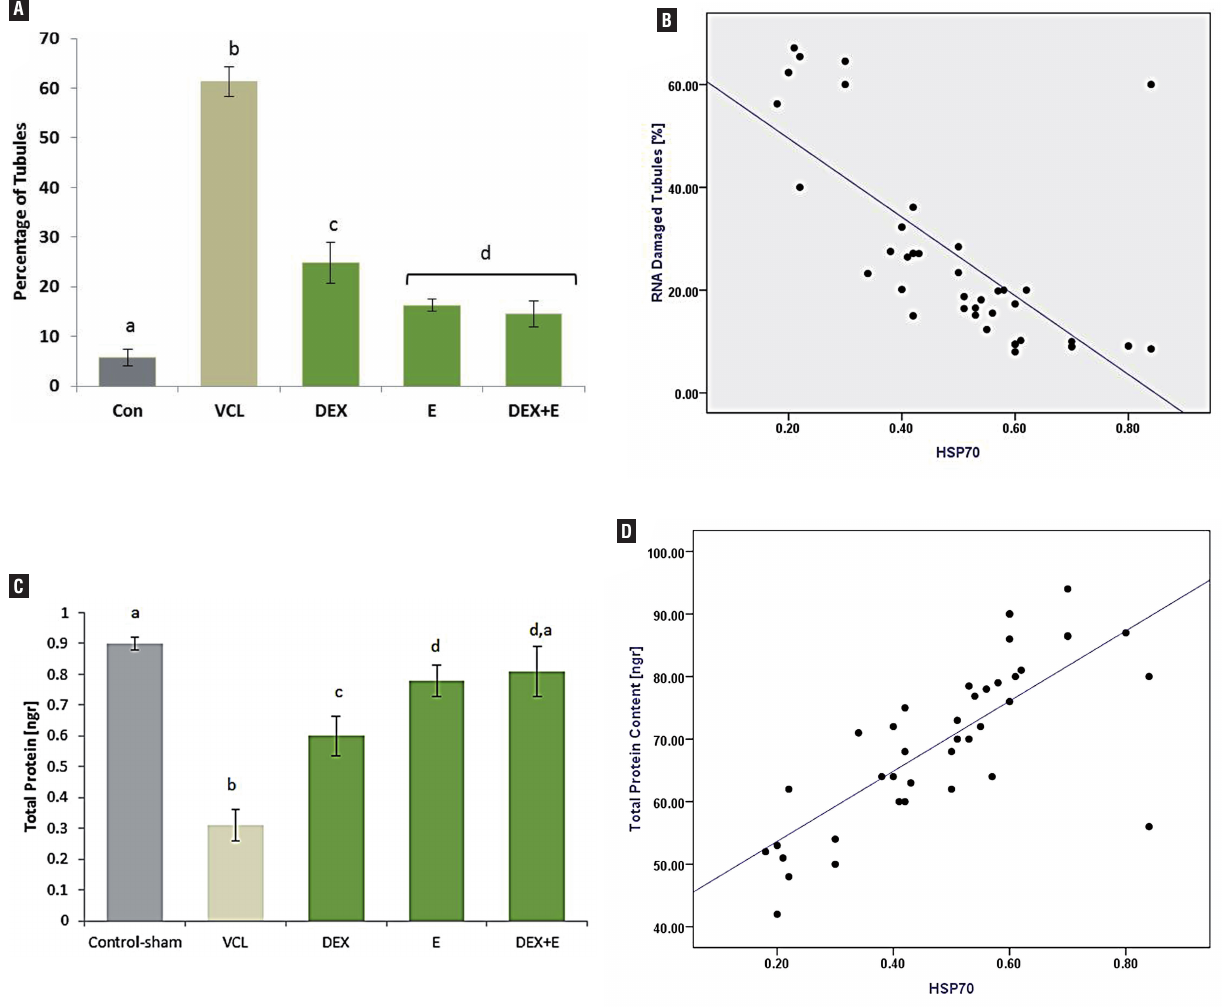
Figure 4 - Effect of VitE (150mg/kg) and DEX (0.125mg/kg) on (A) VCL-increased percentage of tubules with damaged RNA, Vit E and DEX significantly (P<0.05) reduced the VCL-increased RNA damage; (B) Positive correlation between intensity of Hsp70-2 and percentage of tubules with RNA damage in germinal cells (r2 =0.876, P<0.05); (C) Effect of VitE and DEX on testicular total protein level, simultaneous administration of DEX and VitE significantly (P<0.05) elevated testicular protein level; and (D) Positive correlation between intensity of Hsp70-2 with testicular total protein level (r2 = 0.941,